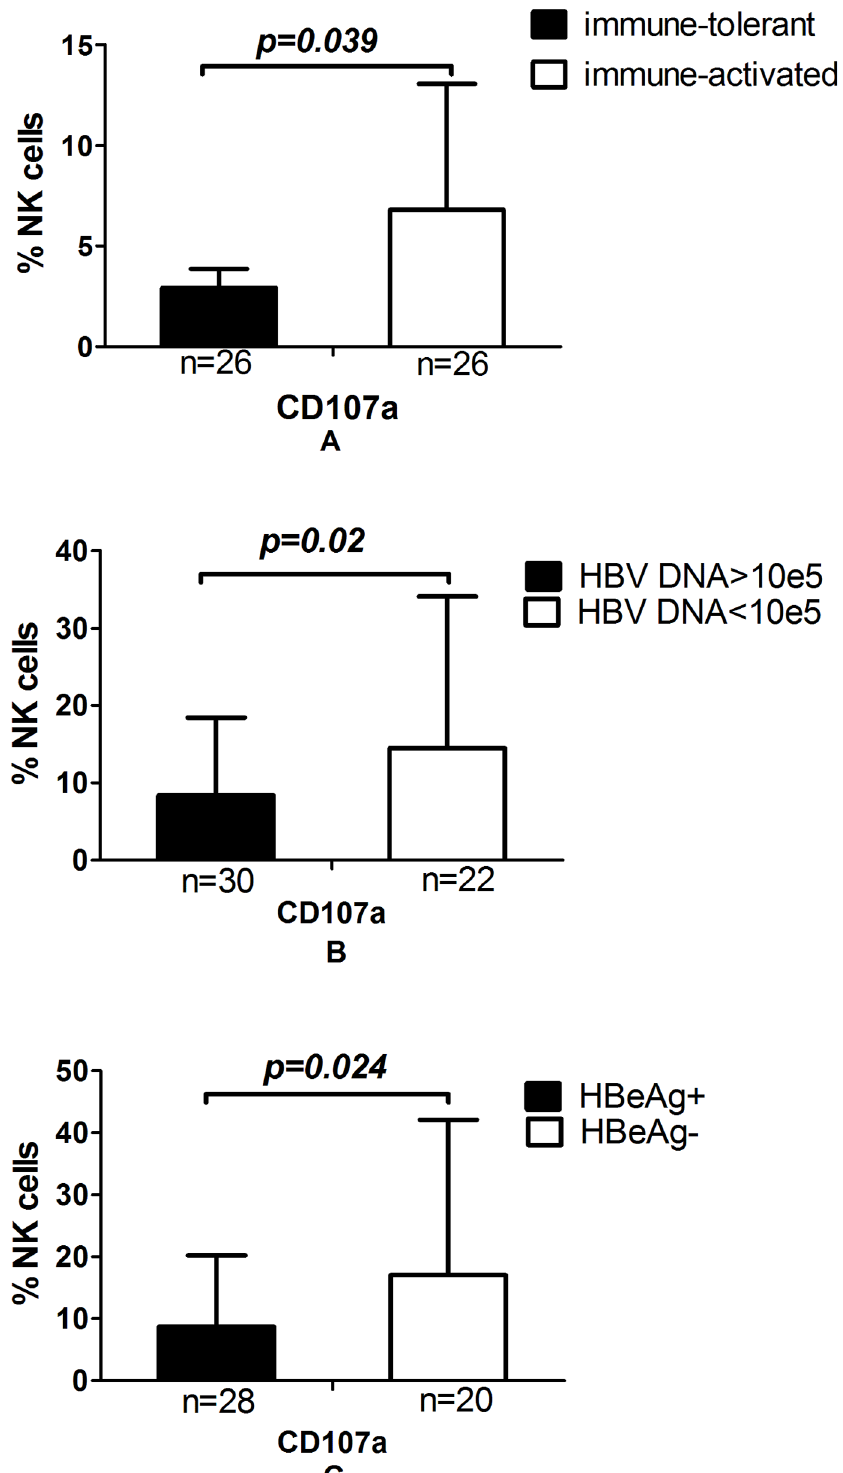
Fig 3. NK cell expression of CD107a was abnormal in CHB patients. (A) Groups divided by immune status. (B) Groups divided by HBeAg levels. (C) Groups divided by HBV DNA levels.